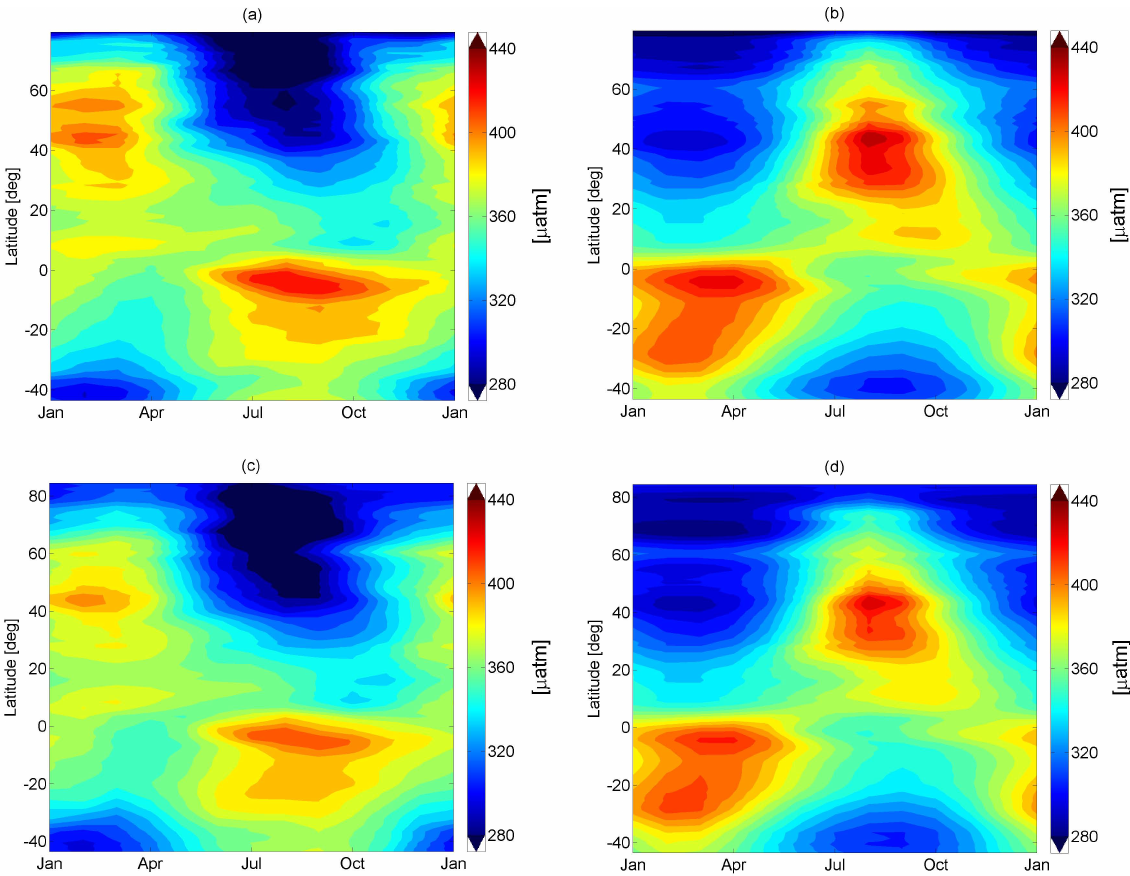
Fig. 10. Mean seasonal cycle of the zonally averaged sea surface p CO 2 driven by (a) the non-thermal component, such as changes in circulation, mixing, and biology, and (b) the thermal component, i.e. the changes in temperature. (c) and (d) show the non-thermal and thermal components respectively for the Takahashi et al. (2009) climatology. The decadal mean p CO 2 has been added to both